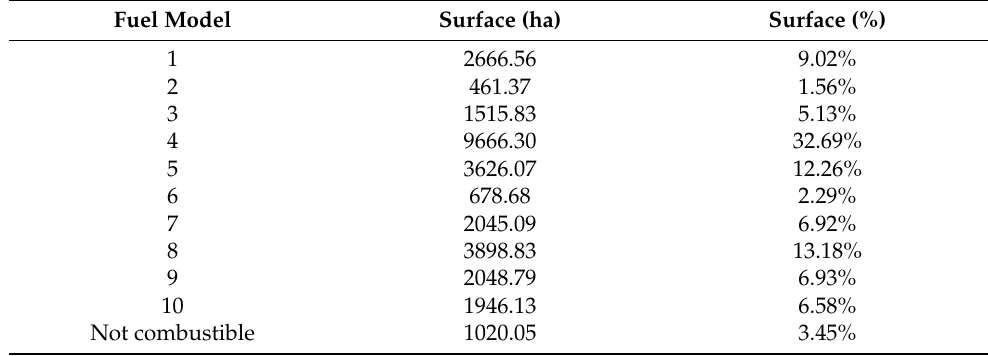
Table 2. Rothermmel’s fuel models of forest types in Sierra de las Nieves National Park (M á laga, southern Spain).